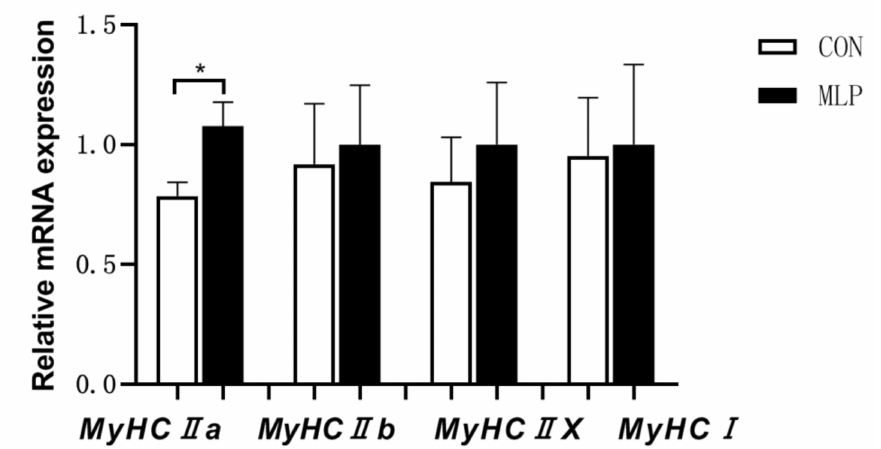
Figure 4. Effect of dietary supplementation with mulberry leaf powder (MLP) on mRNA expression of myosin heavy-chain (MyHC) isoform genes in longissimus thoracis (LT) muscle of Tibetan pigs. Data are expressed as means ± SEM. * indicates a significant difference ( p < 0.05) between the MLP group and the control (CON) group. N = 6.